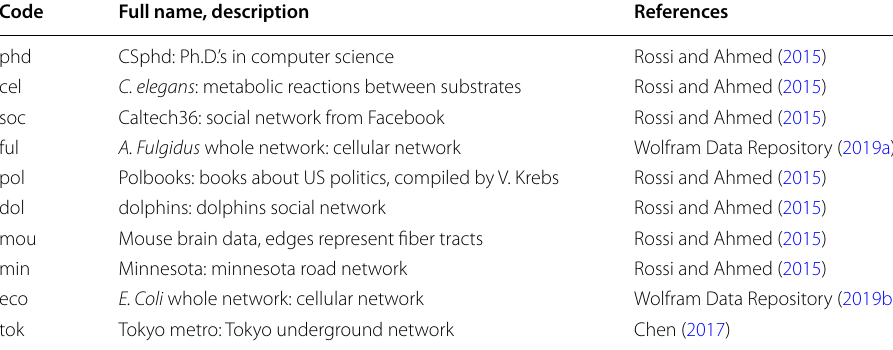
Table 3 Structural properties of the analyzed networks